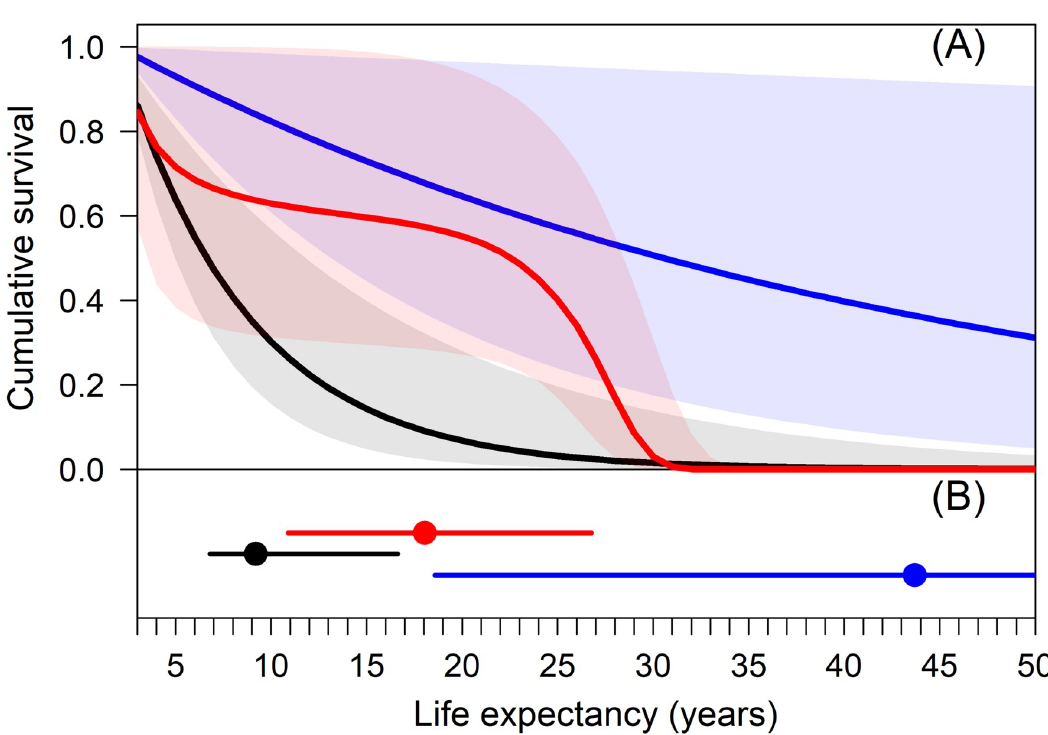
Fig 5. Cumulative survival (A) and life expectancy (B) of western Hudson Bay polar bears from Jolly-Seber models that ignore age structure (black) or incorporate age structure and assume annual survival is constant (blue) or a quadratic function of age (red). Posterior medians and 95% credible intervals are shown. Cumulative survival and life expectancy estimates are conditional on surviving to two years of age (i.e., independent bears). Upper credible bound for life expectancy from the age structure model with constant survival is > 100 years and not shown (see